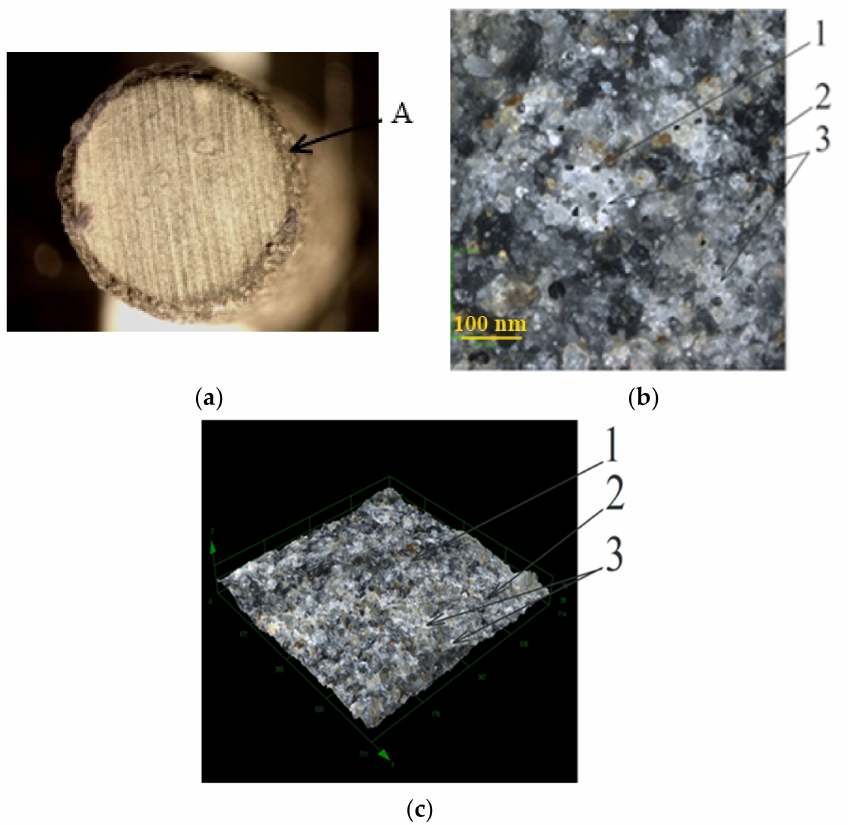
Figure 7. ( a ) Section of basalt FRP rebar, d = 10 mm. A mix of basalt fiber and microsilica, applied by spraying followed by calcinations; ( b ) planar SEM image view; ( c ) panoramic SEM image